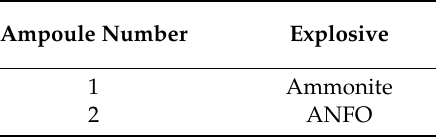
Figure 3. ( a , b ) Diagram of explosive setups; ( c , d ) photograph of explosive setups. Table 1. Explosive